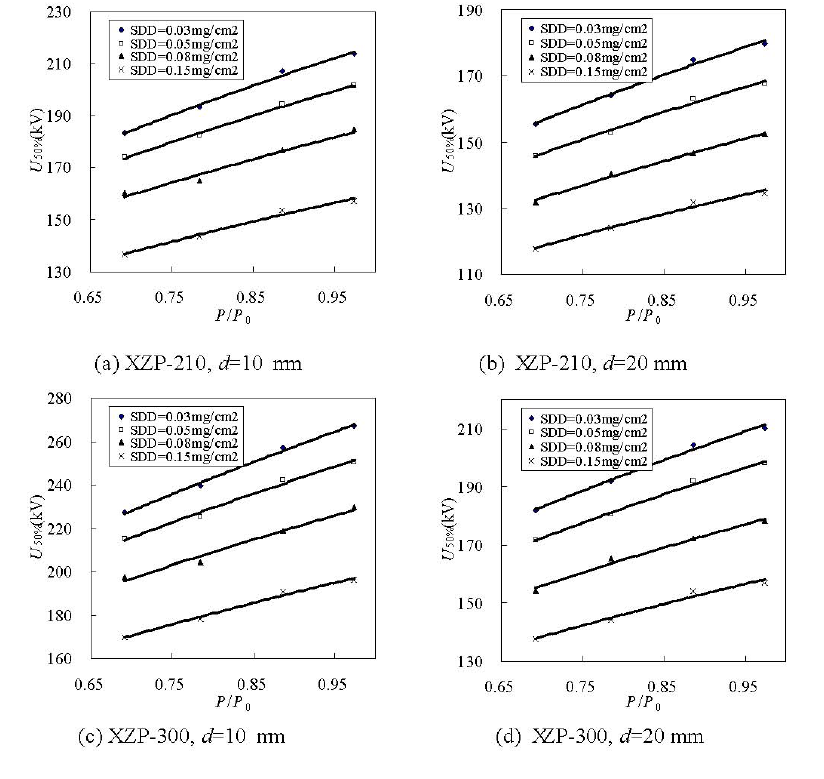
Figure 10. Relationship between U